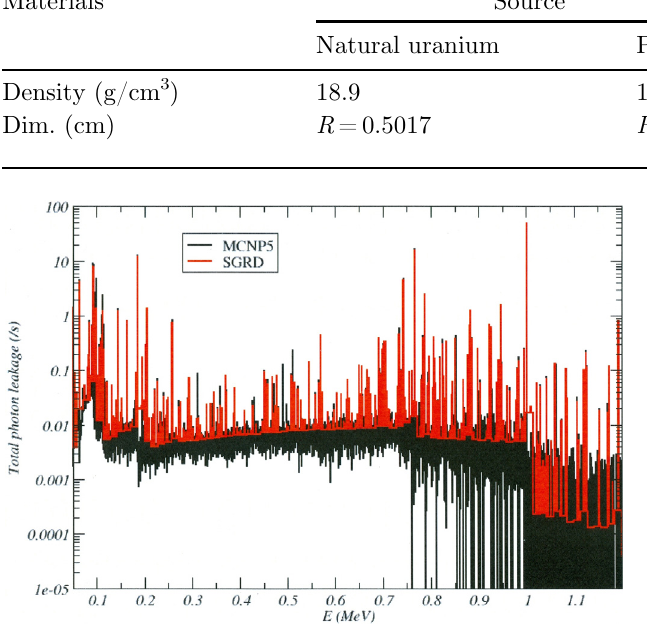
Fig. 6. Source leakage spectra calculated using MCNP5 and SGaRD.